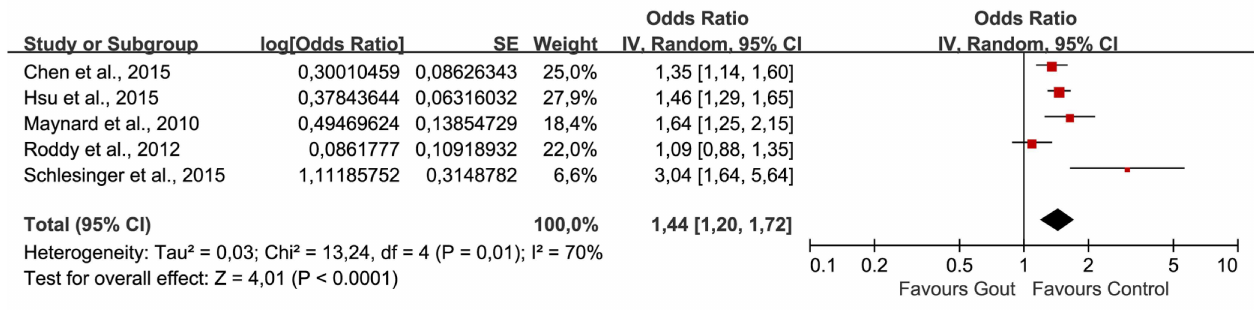
Fig 2. Forest plot of gout and ED: unadjusted OR.